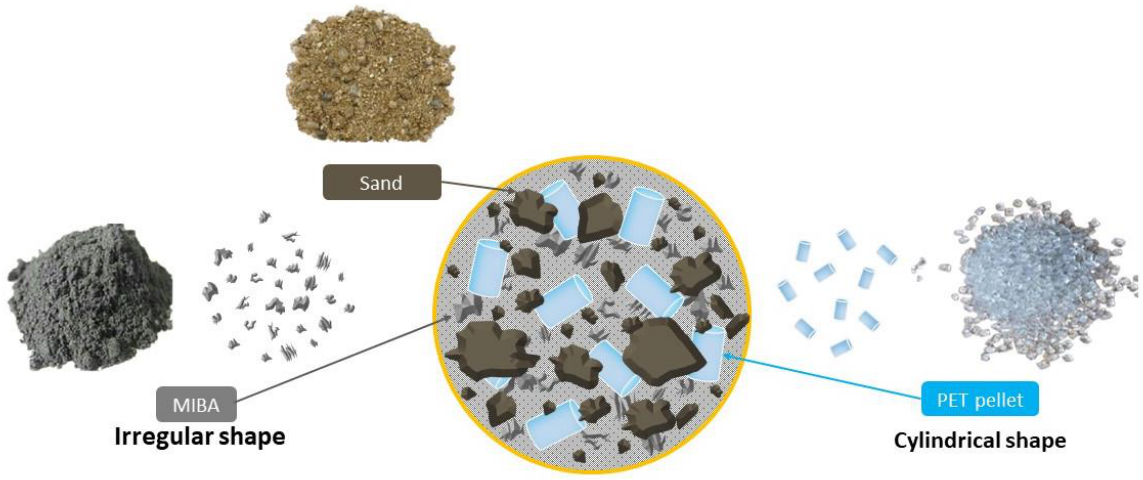
Figure 2. General appearances of sand, MIBA, and PET pellets.